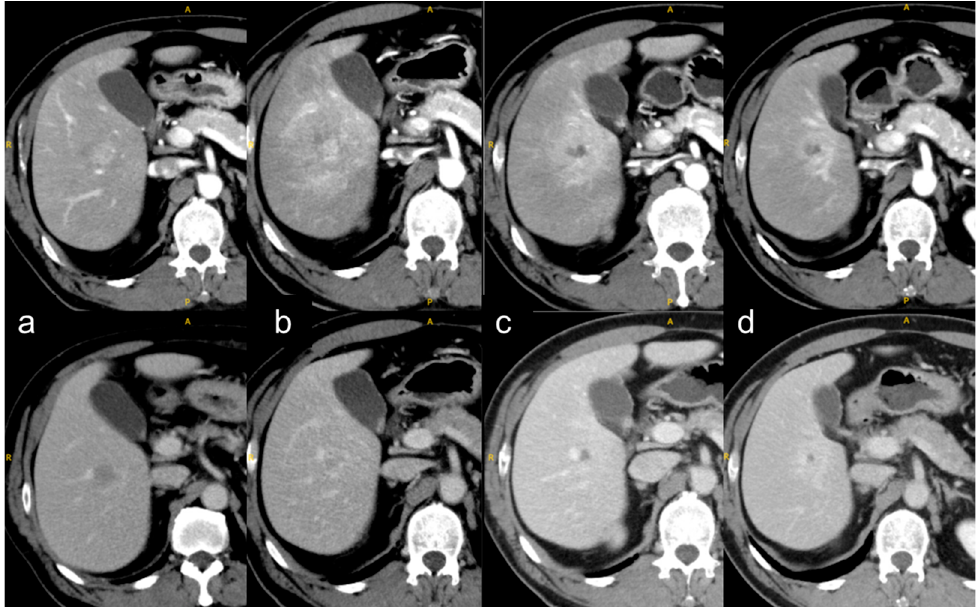
Figure 1. Focal liver reaction and its time course. ( a ) Before SBRT, a tumor showed early-phase enhancement (top row) and portal-phase washout (bottom row); ( b ) at 1 month after SBRT, a focal liver reaction with early-phase enhancement around the tumor, corresponding to a 20-Gy irradiated area (not shown here); ( c ) at 4 months, the focal liver reaction shrank and the early-phase enhancement of the tumor disappeared; and ( d ) at 8 months, the focal liver reaction shrank further. The yellow letters A, P, and R indicate anterior, posterior, and right, respectively.